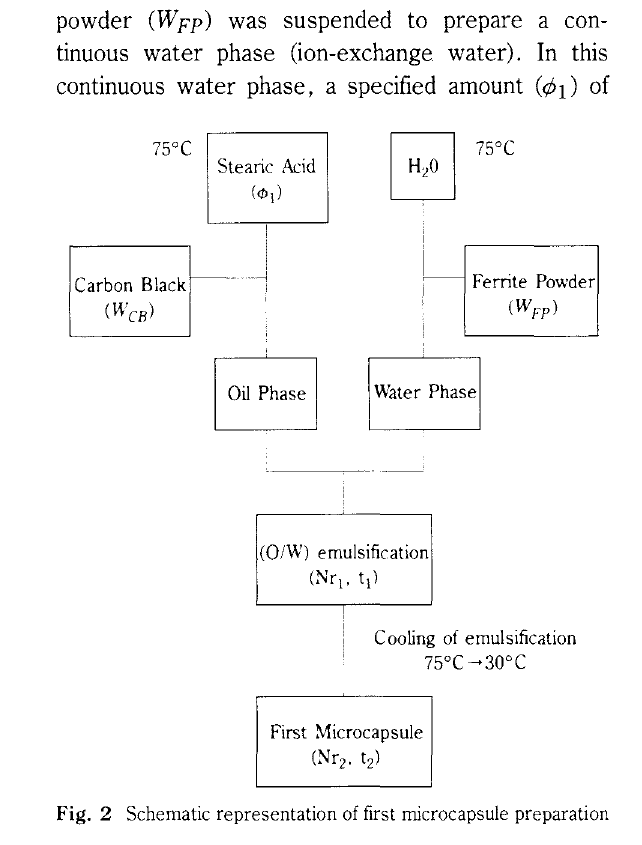
Fig. 2 Schematic representation of first microcapsule